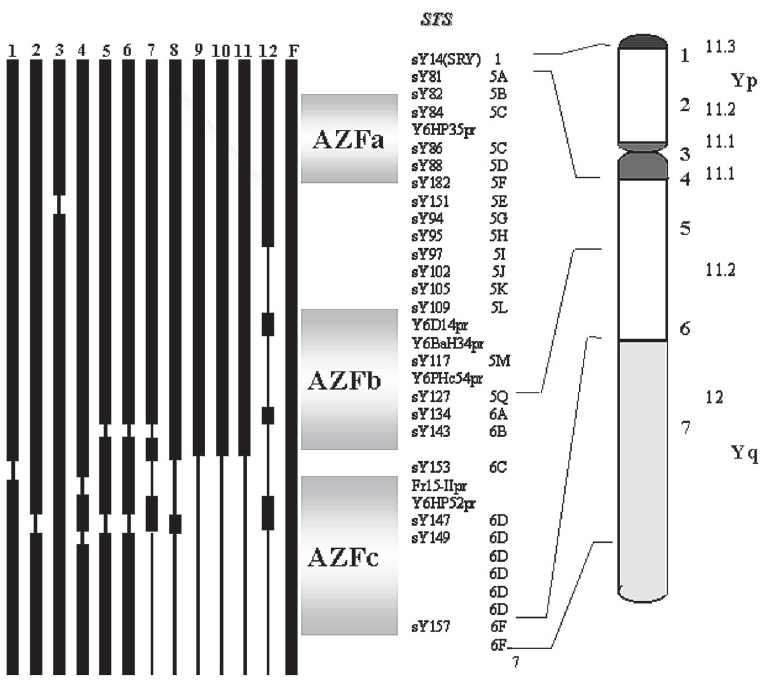
Figure 3. Schematic presentation of the 12 patients with microdeleted segments inside the azoospermia factor gene (AZF) region of the Y chromosome. The patients are positioned by the number of sequence-tagged sites (STS) deleted (in the same order in which they are presented in Table 1). F = fertile